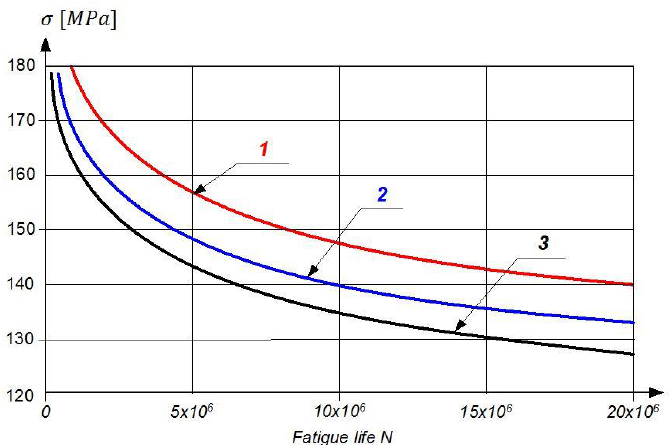
Figure 5. The fatigue curves of turbine blades made of EI-437B, where the working time t = 0 h (1), t = 200 h (2), and t = 400 h (3) [15].